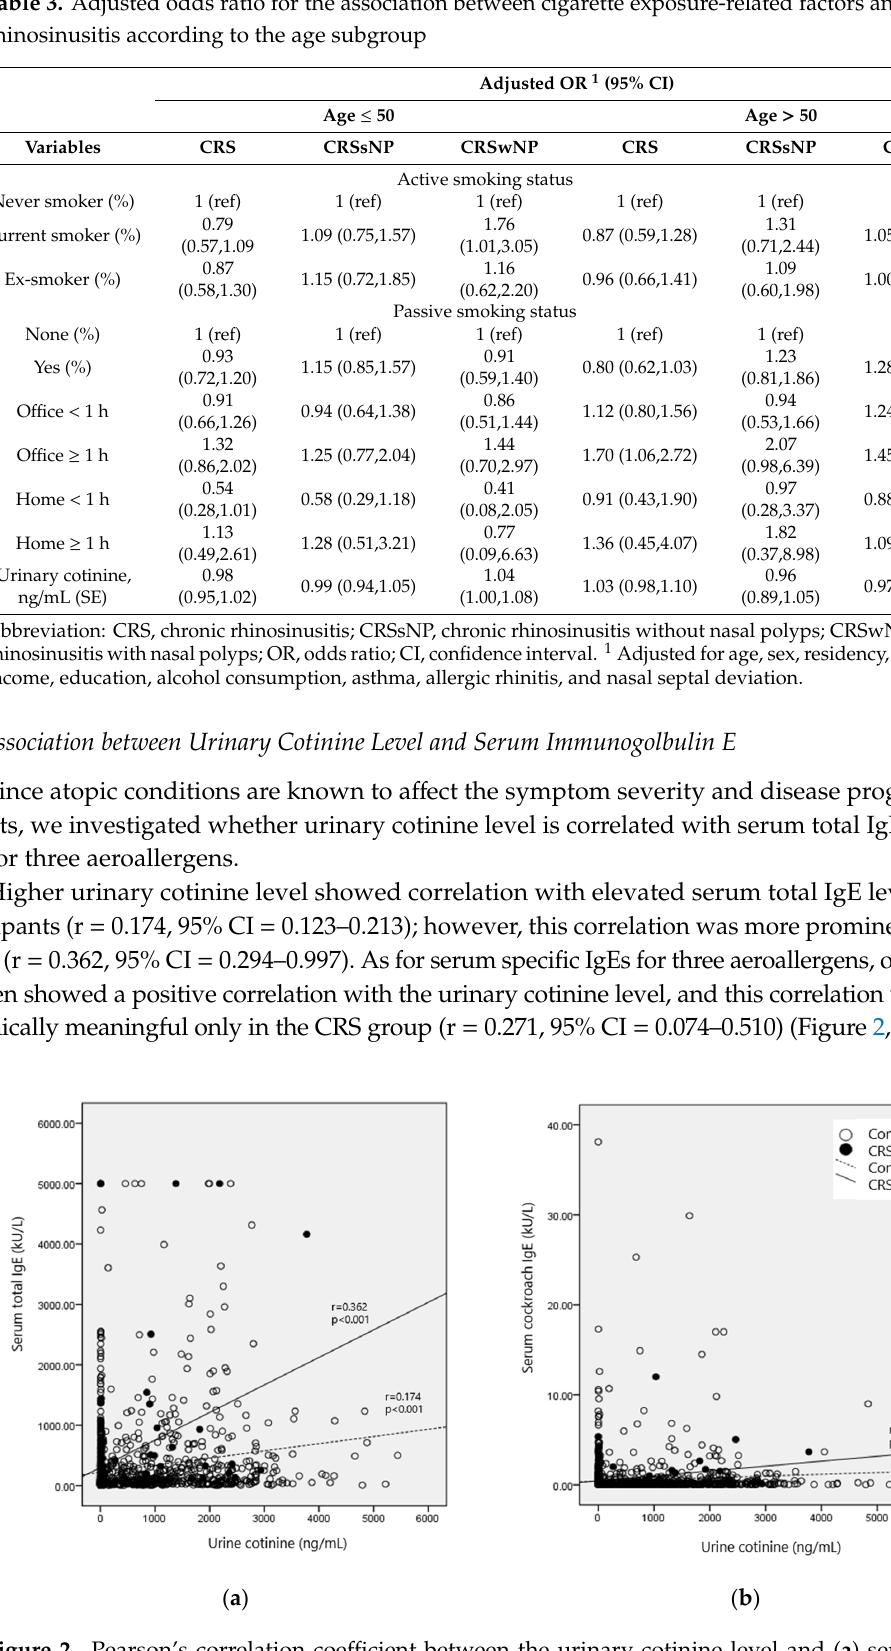
Figure 2. Pearson’s correlation coefficient between the urinary cotinine level and ( a ) serum total Immunoglobulin E (IgE); ( b ) serum cockroach IgE levels. Further dose–response relationships between serum total IgE, serum cockroach IgE, and urinary cotinine levels using multiple linear regression after adjustment for confounding factors were analyzed. Serum total IgE levels increased with increasing urinary cotinine levels in both the control ( β = 0.062, 95% CI = 0.021, 0.103) and the CRS group ( β = 0.493, 95% CI = 0.071–0.916), with a greater correlation identified in the CRS group. 4. Discussion In this cross-sectional study using nation-wide survey data, active smoking status was closely related with CRSwNP in younger adults aged below 50, while no meaningful association was identified in either the CRSwNP in older adults or in CRSsNP. This finding was consistent with the association between urinary cotinine and CRS. In addition, the serum urinary cotinine level was correlated with higher serum total IgE levels, and this correlation was stronger in CRS participants compared to the control. Numerous studies have investigated the effect of cigarette smoke exposure on CRS and most of them are based on a self-reported questionnaire. In this nationwide survey-based study, we used urinary cotinine levels and self-reported smoking status to identify the association between smoking and CRS. Cotinine, as an objective indicator of cigarette smoke exposure, has been rarely used in assessments, although it is a sound objective determinant of smoking. A major metabolite of nicotine, cotinine is considered a reliable biomarker reflecting smoking conditions because of its longer half- life (16–20 h) than nicotine (2 h) [12,13]. Cotinine can be detected in body fluids including saliva,